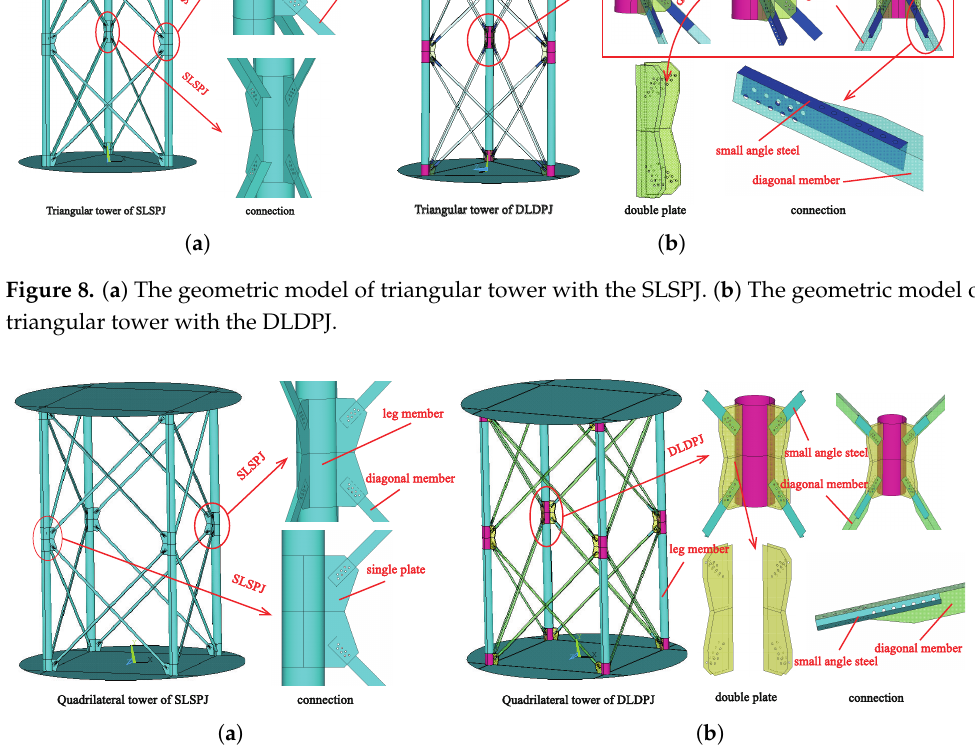
Figure 9. ( a ) The geometric model of quadrilateral tower with the SLSPJ. ( b ) The geometric model of quadrilateral tower with the